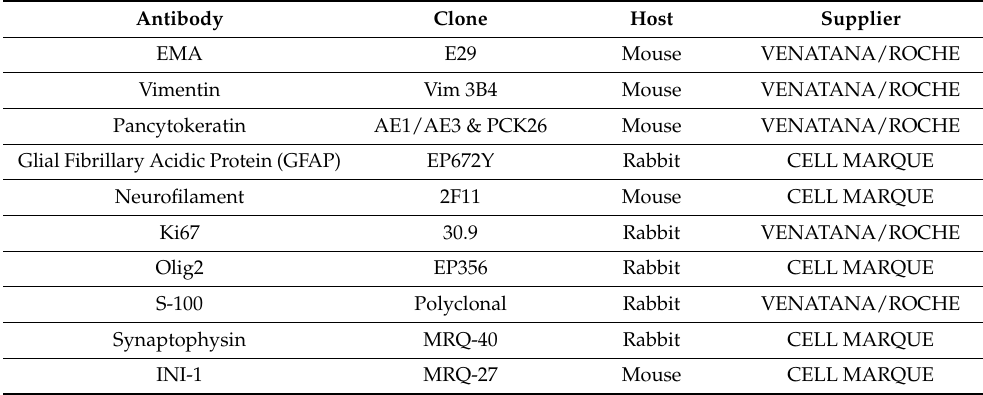
Table 1. The list of antibodies used in the immunohistochemical